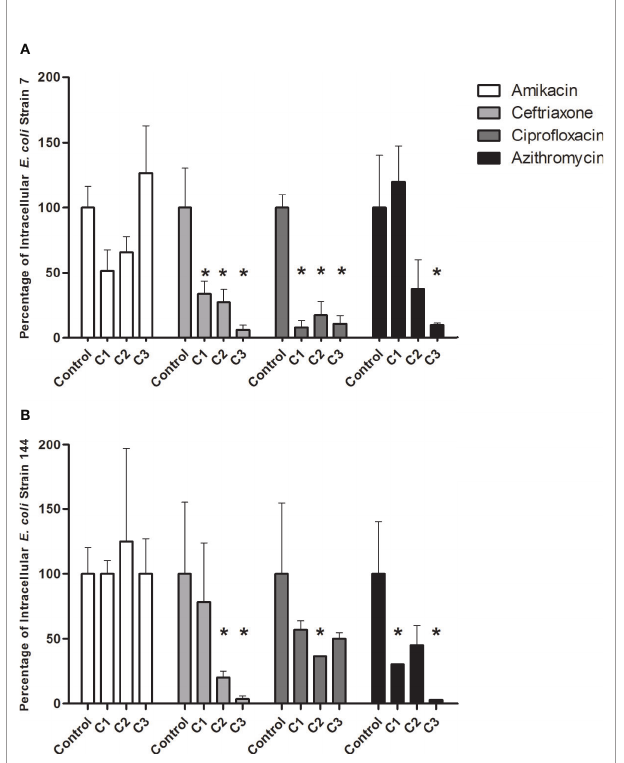
FIGURE 5 | Percentage of intracellular bacteria after antibiotic treatment. (A) , strain 7. (B) , strain 144. The values obtained after infection without antibiotics was the control and was set as 100%. After each treatment, the percentage of surviving intracellular bacteria was calculated according to the control. The asterisk represents the cases were signi fi cant values were obtained compared with each control (P < 0.05). Statistical: Mann-Whitney non- parametric test. The assay was performed in